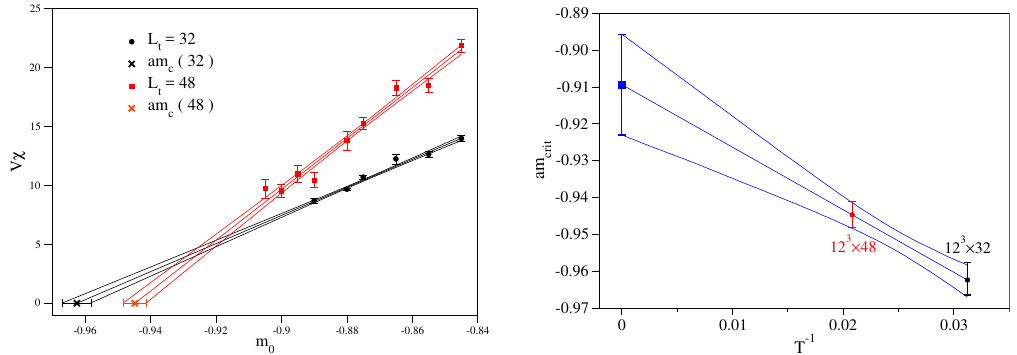
Figure 10 . The left panel shows extrapolations to vanishing topological susceptibility on 12 3 (cid:2) 32 and 12 3 (cid:2) 48 lattices. The right plot illustrates the in(cid:12)nite volume limit of this